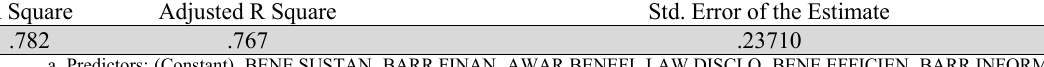
The summary of the results R Square Adjusted R Square Std. Error of the Estimate .782 .767 .23710